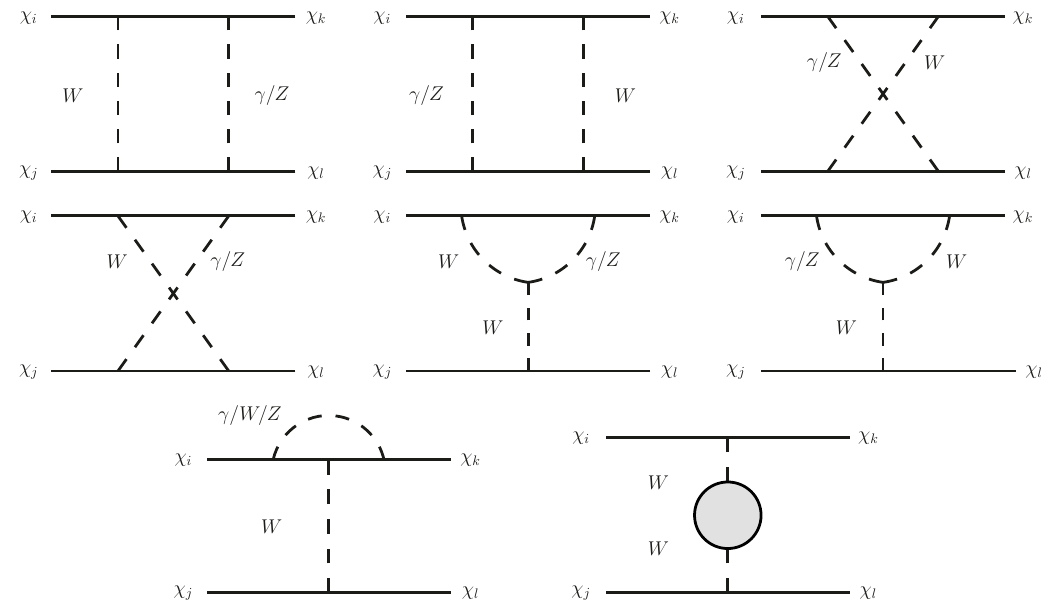
Figure 1 . Relevant one-loop topologies correcting the tree-level W -exchange channel χ i χ j → χ k χ l channel excluding wave-function and counterterm topologies. Also symmetric diagrams, e.g., vertex corrections at the lower line are not explicitly